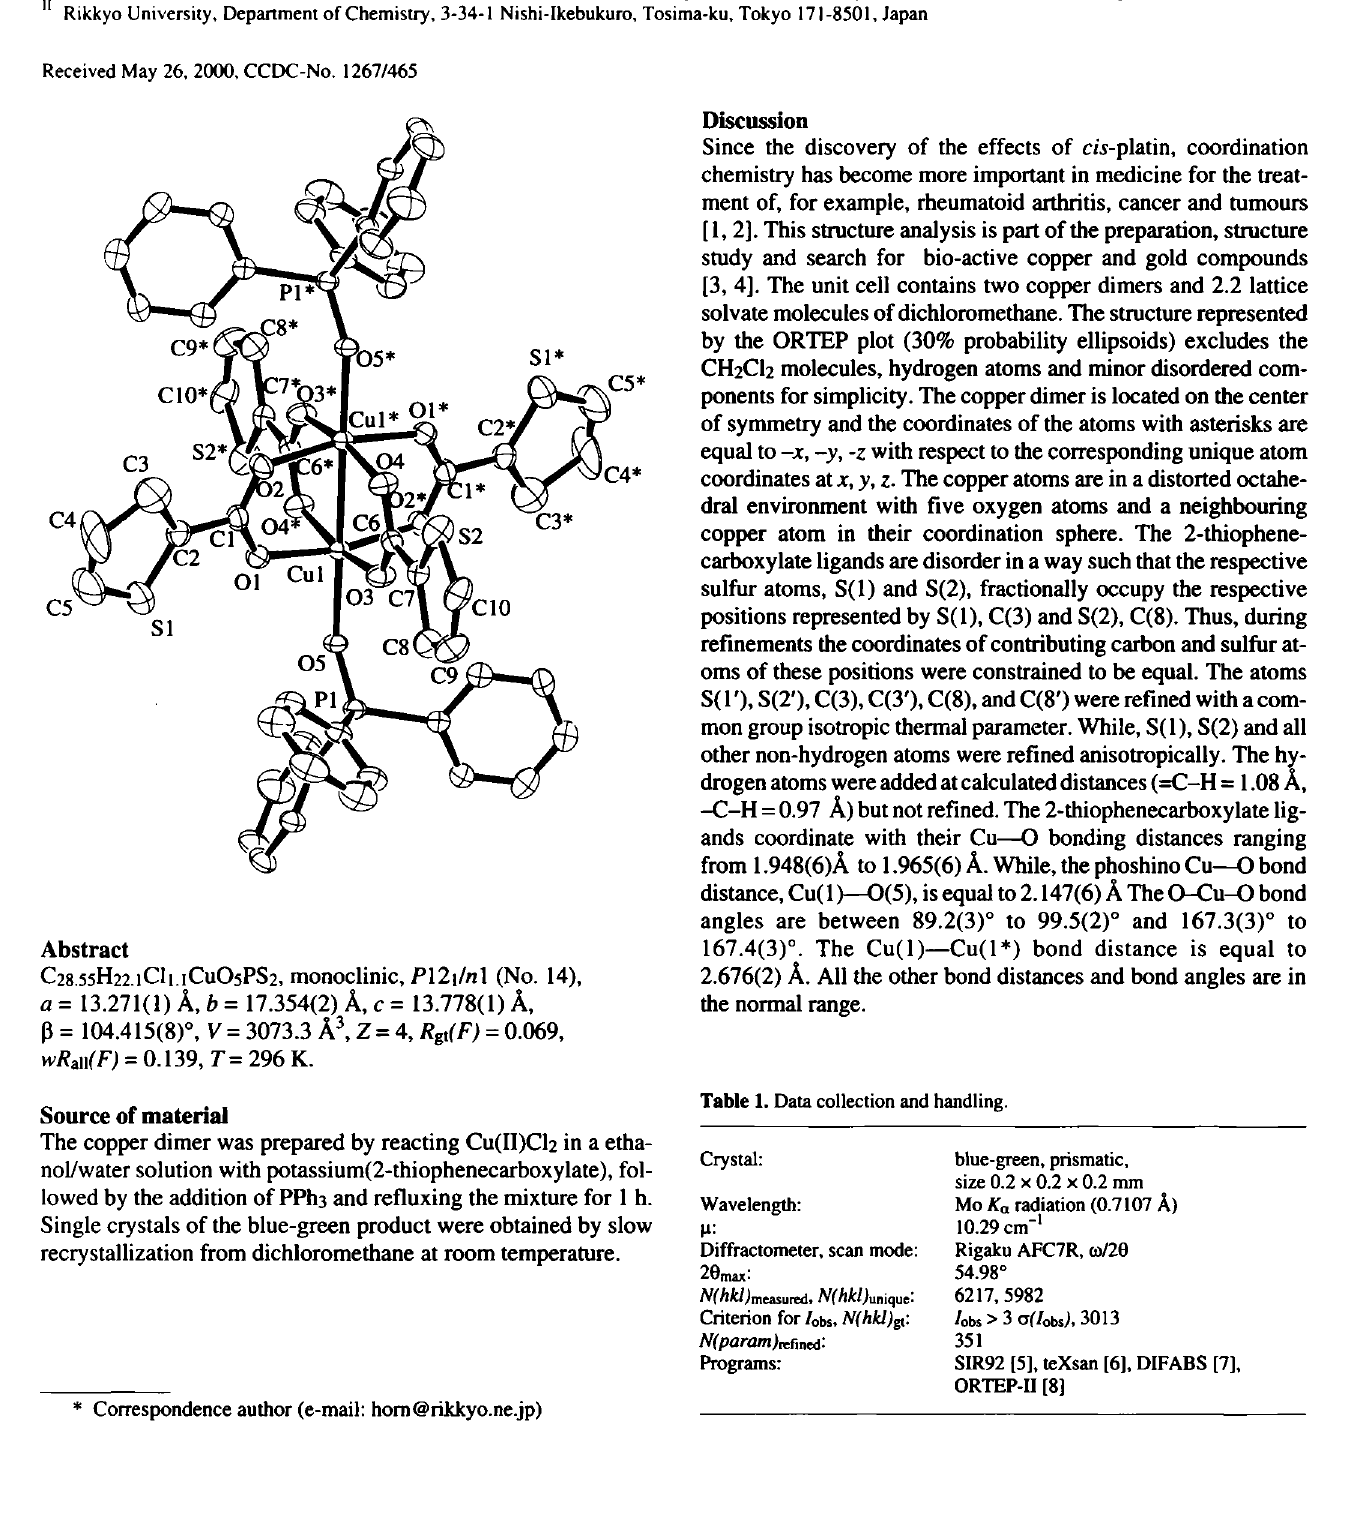
Table 1. Data collection and